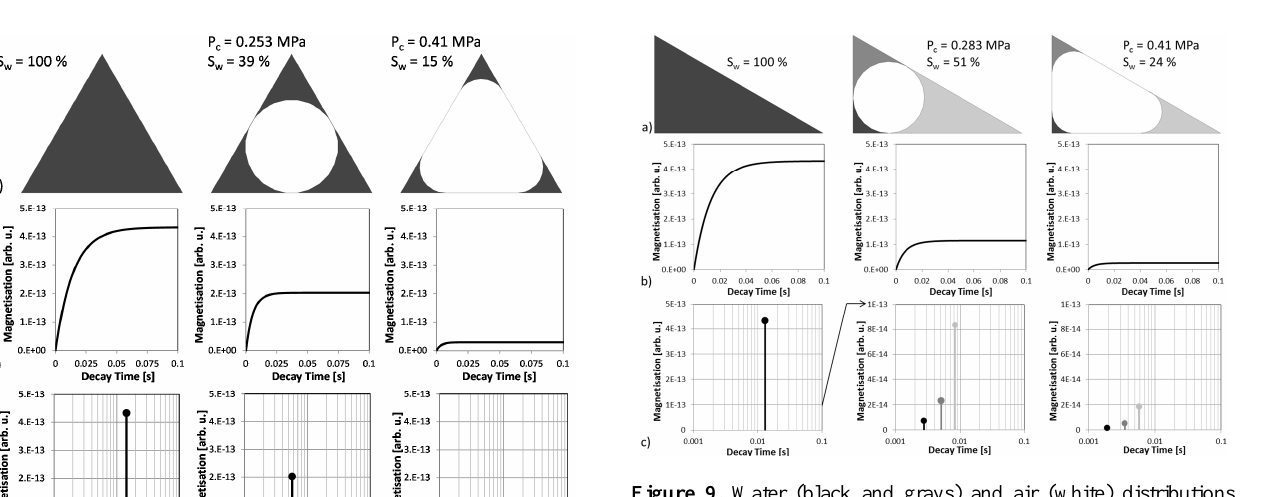
Figure 9. Water (black and grays) and air (white) distributions within a right-angled triangular pore ( A 0 = 4 . 33 × 10 − 13 m 2 , ρ s = 10µms − 1 ) at different capillary pressures for imbibition (a) with corresponding evolution of the (longitudinal) magnetization (b) and NMR T 1 relaxation times (c)